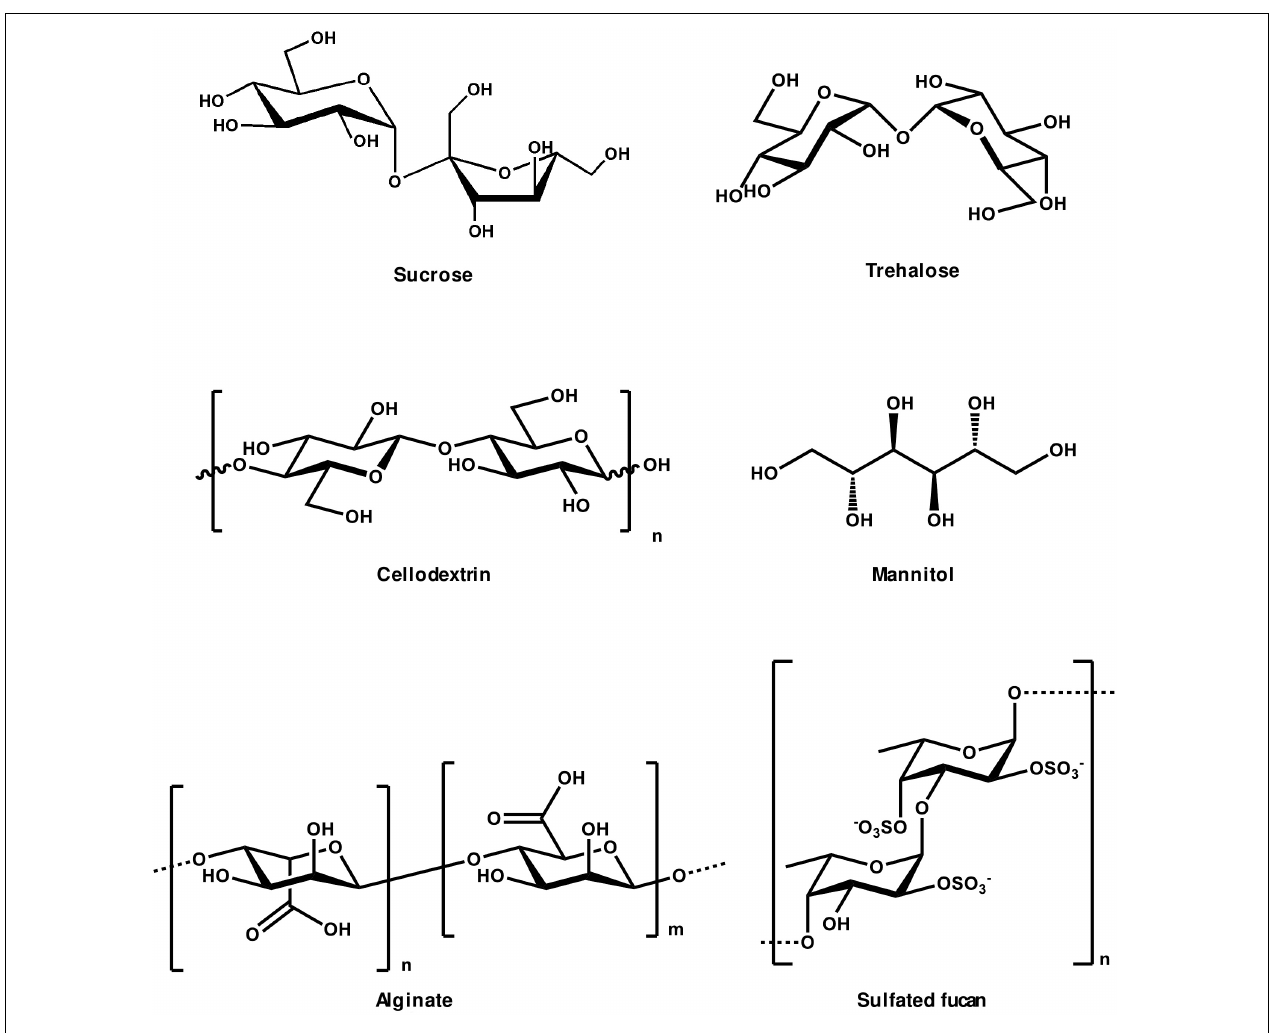
FIGURE 2 | Chemical structures of oligosaccharides showing elicitor